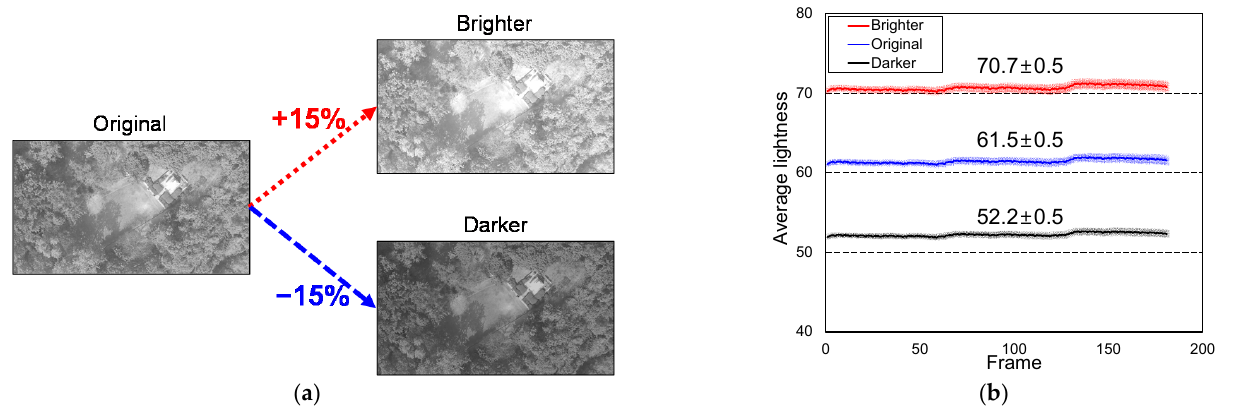
Figure 5. ( a ) The images of AL50, AL60, and AL70 and ( b ) the average lightness of all of the frame images.